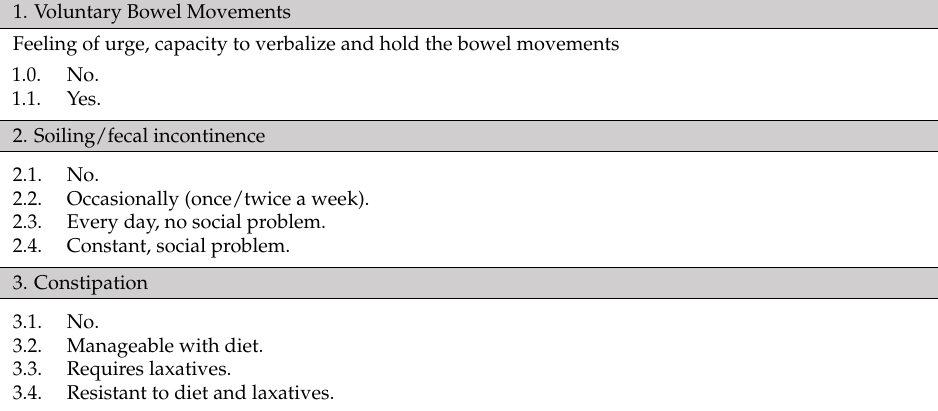
Table 1. International classification (Krickenbeck’s scale). KS represents the gold standard for the classification of AnoRectal Malformations, divided in three sections (1. Voluntary bowel movements, 2. Soiling/fecal incontinence, 3. Constipation), used in the management of the